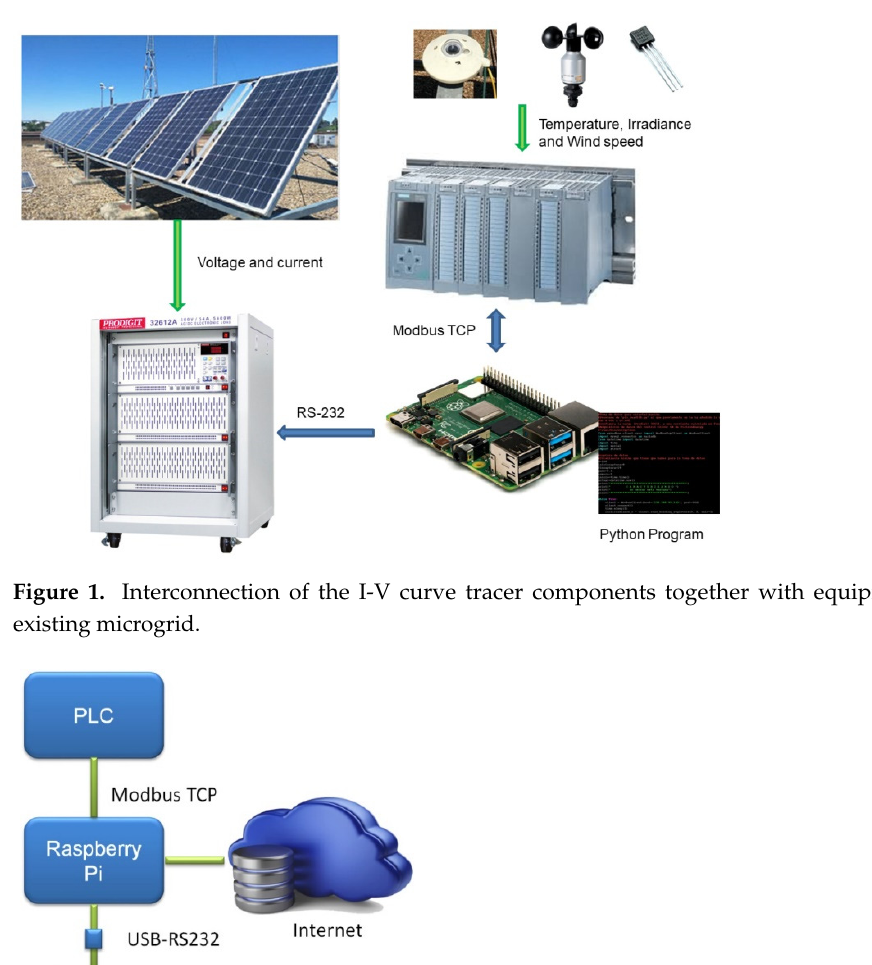
Figure 1. Interconnection of the I ‐ V curve tracer components together with equipment of the existing microgrid.